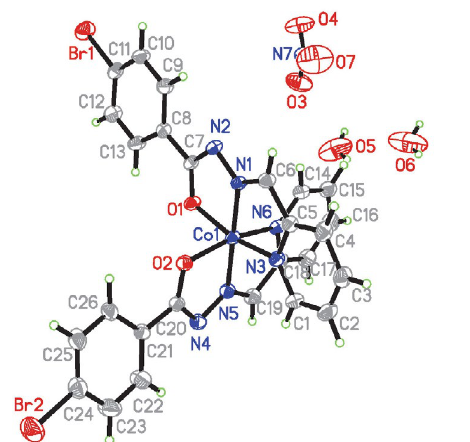
Figure 3. Molecular structure of 1 , showing the atom-numbering scheme. Displacement ellipsoids are drawn at 30% probability